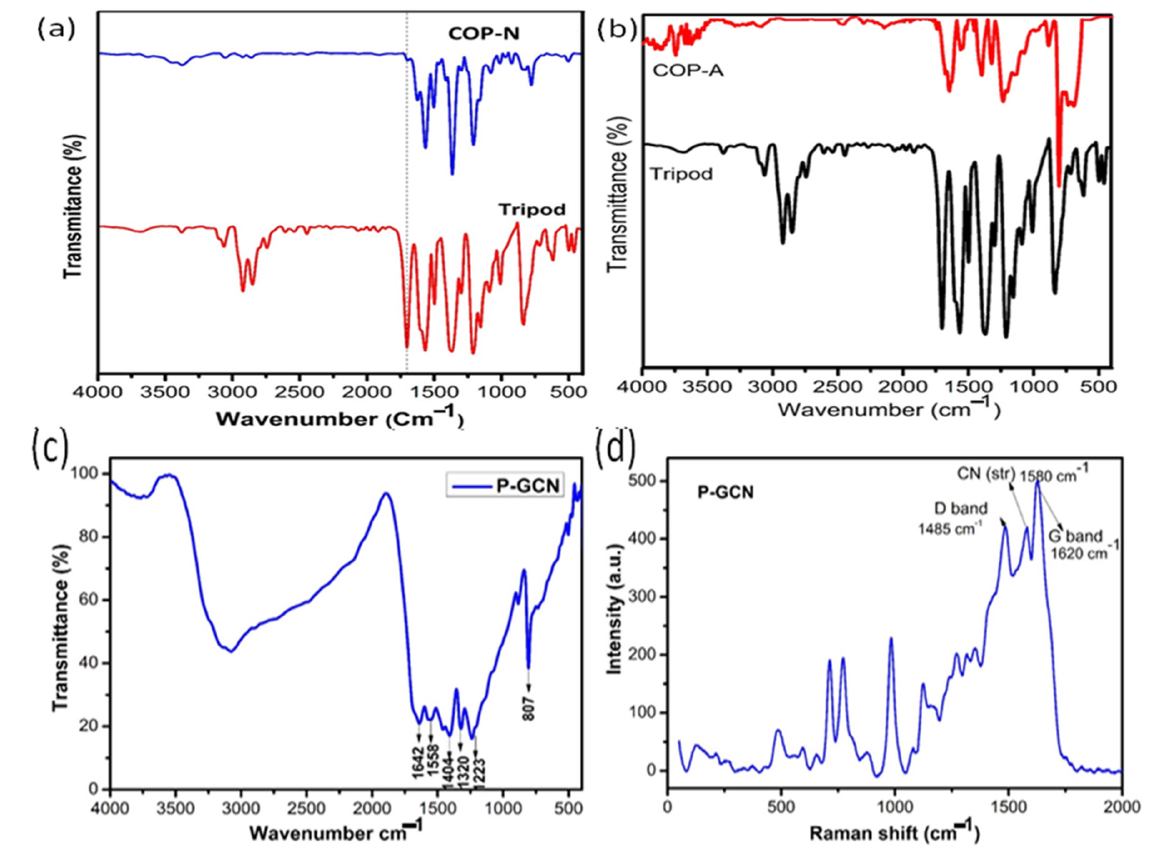
Figure 2. FT-IR spectra of ( a ) COP-N, ( b ) COP-A, ( c ) P-GCN and ( d ) Raman spectrum of P-GCN.